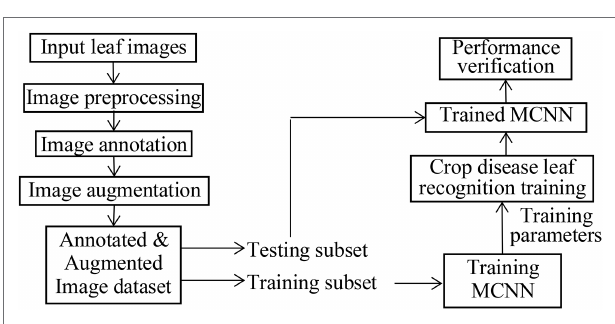
FIGURE 5 | Framework of the proposed